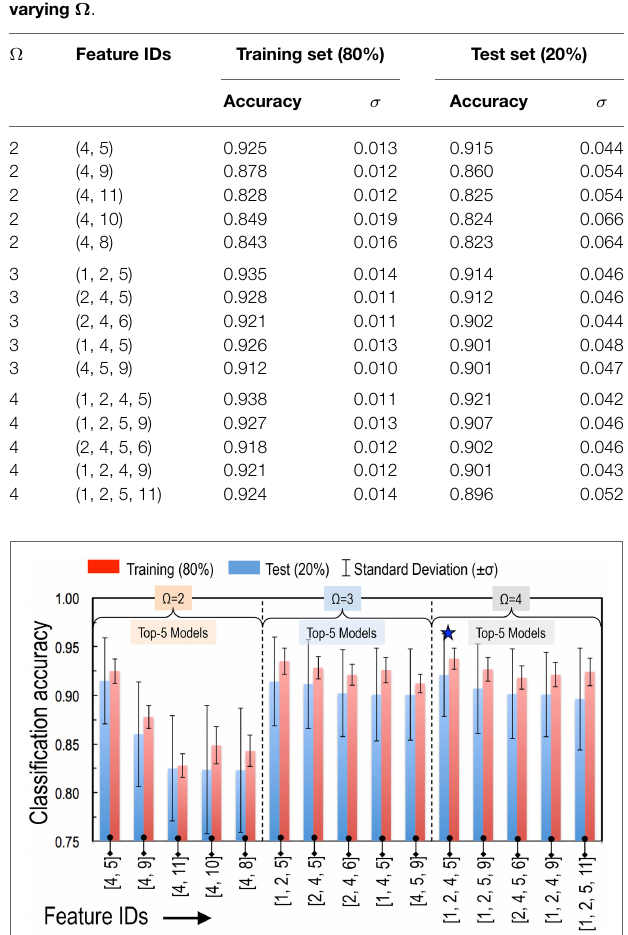
FIGURE 2 | Performance of top-5 models for each of the cases with two features ( Ω= 2), three features ( Ω= 3), and four features ( Ω= 4) . Models were ranked by their prediction accuracy defined as fraction of the correctly predicted formability labels on a 20% test set that was not used for model training. To obtain reliable statistics of our model performance, we performed 500 such trials of randomly choosing 80% for training and 20% for testing. At the end of each trial, we have an estimate for the accuracy of the model performance on each test set. Error bars represent the SD ( (cid:27) ) of those 500 accuracy estimates. The best performing model is identified with a ⋆